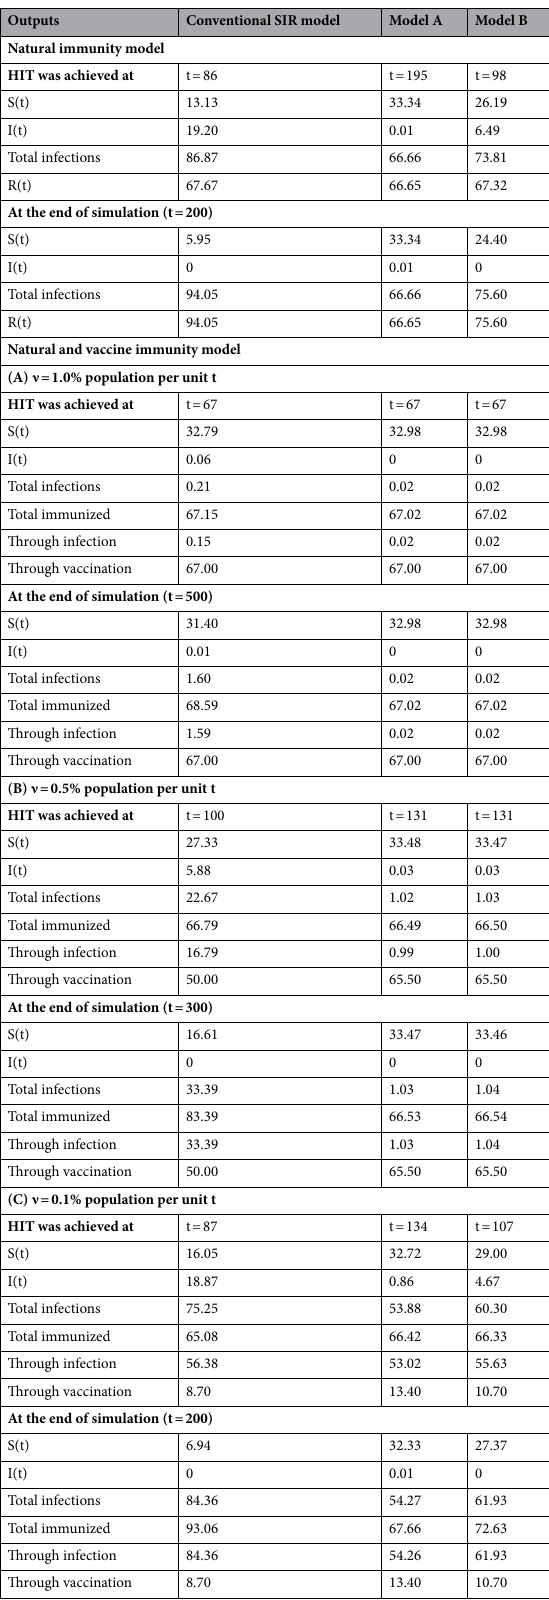
Table 3. Outputs of simulations using the conventional SIR model, Model A and Model